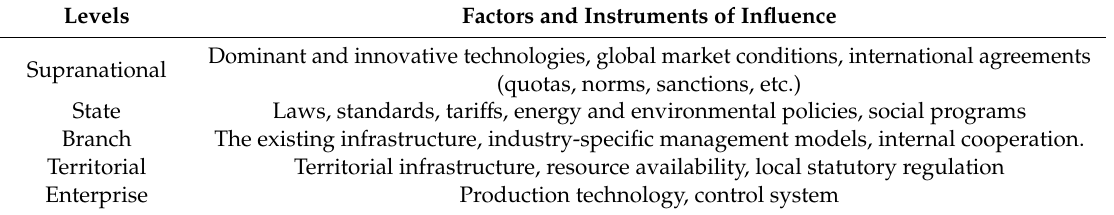
Figure 1. Schematic representation of energy management levels. Source: personal elaboration. The level of energy costs was formed under the influence of factors of all levels. Each energy management level has a specific set of influence tools (Table 2). Table 2. Energy Management Levels